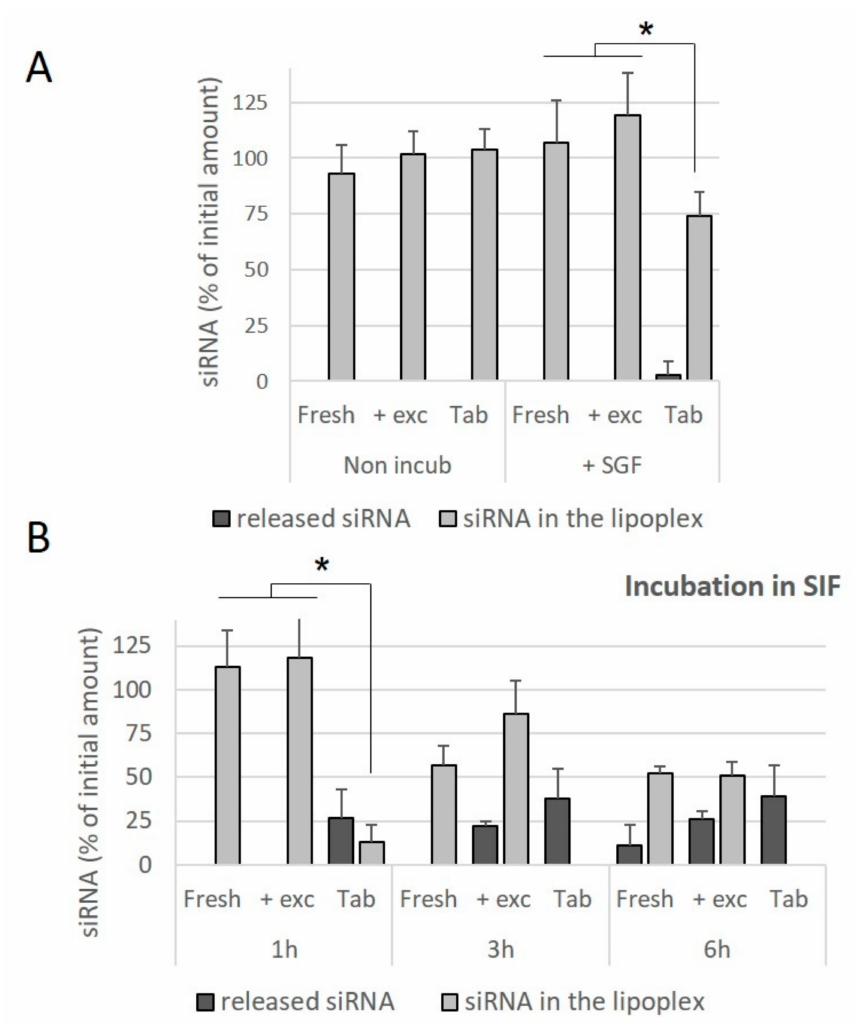
Figure 7. Effect of the incubation in excipients and simulated gastrointestinal conditions on the stability of siRNA lipoplexes. siRNA lipoplexes were diluted in excipients (trehalose, mannitol and lactose) obtained from the disintegration of a placebo (without lipoplexes) tablet (+ exc) and compared with freshly prepared lipoplex (Fresh) or lipoplex resuspended from tablets (Tab) after incubation for 1 h at 37 ◦ C in SGF ( A ) or for 1 h, 3 h and 6 h at 37 ◦ C in SIF ( B ). Nonincubated (Non-incub) samples were also studied. The percentage of siRNA released or preserved within lipoplex was quantified by gel electrophoresis as described in Material and Methods. The results were expressed as % initial amount of siRNA used (mean values ± SD, n = 3, * statistical significance between different treatments applied to the same type of lipoplex, * p <